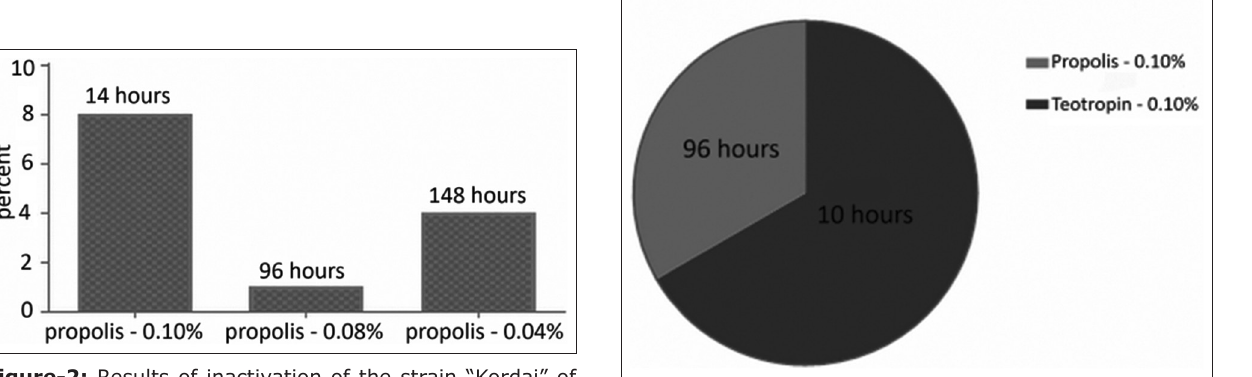
Figure-2: Results of inactivation of the strain “Kordai” of the Aujeszky virus by different concentrations of propolis at a temperature of the reaction medium 37°С.